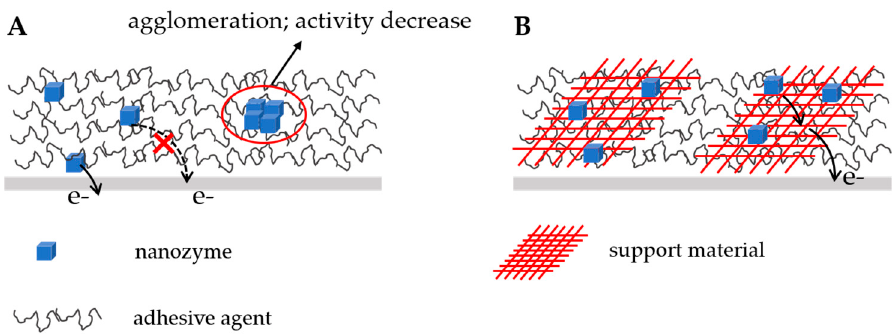
Figure 3. ( A ) Scheme of a traditional nanozymatic sensor. ( B ) Scheme of a support material– nanozyme composite sensor.